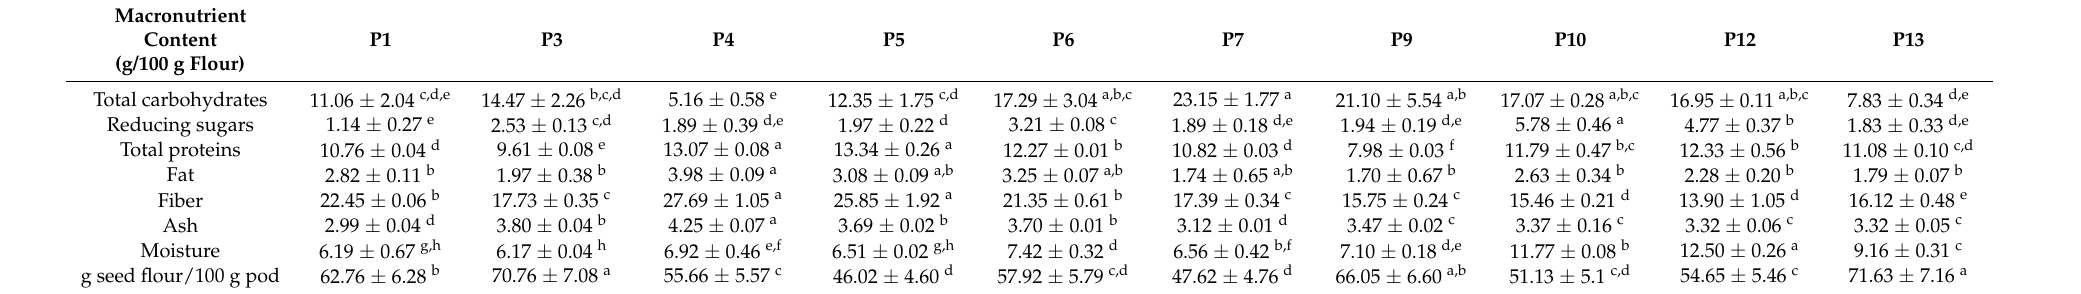
Table 1. Proximal composition of the seed flour from 10 clones of Prosopis alba